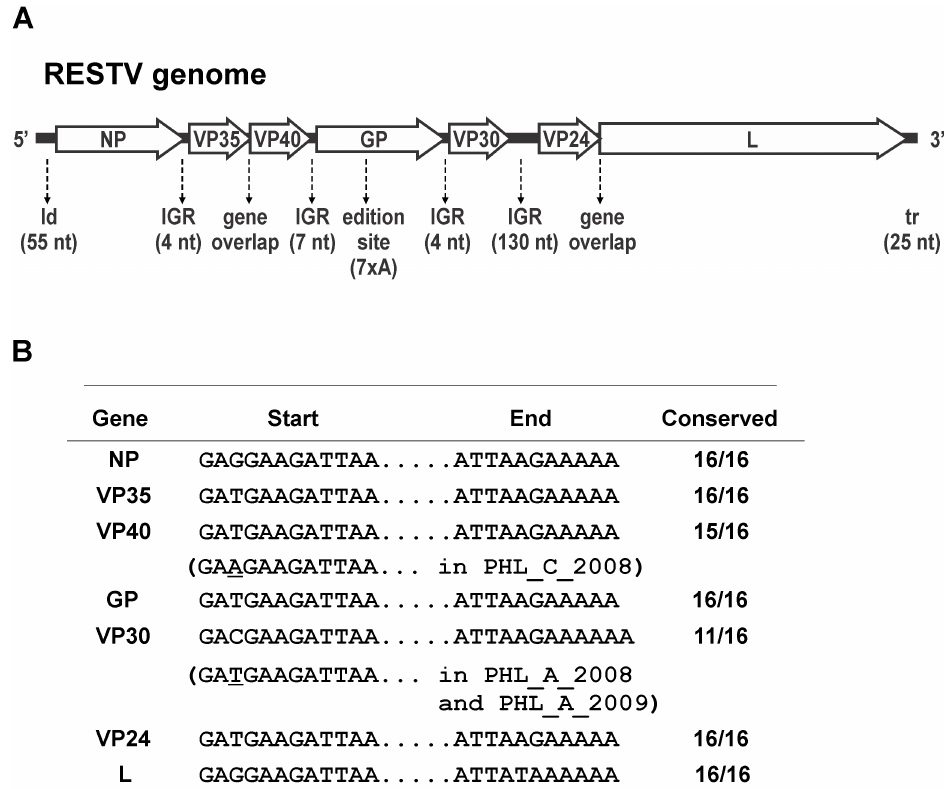
Fig 3. A. Schematic representation of RESTV genomein the viral complementary sense with the 7 encoded genesdepicted in the 5 0 to 3 0 orientation.Major sequencefeatures are indicatedbelowthe genomeschematic with nt length in parenthesis: leader(ld), intergenicregion(IGR), geneoverlaps, GP edition site, and trailer (tr). B. Conservedsequencesat the start and end of each gene are indicated. Singlenucleotidechangesare also indicatedwith